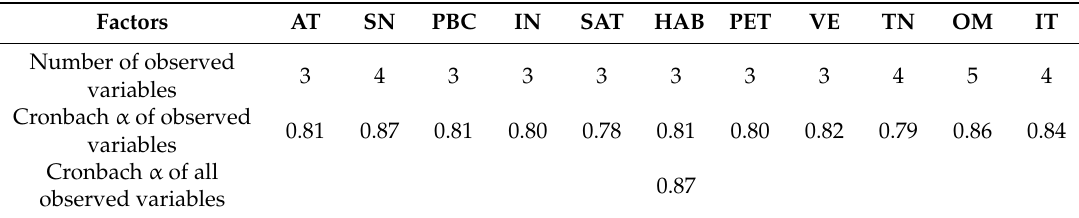
Table 2. Cronbach’s Alpha ( α ) for